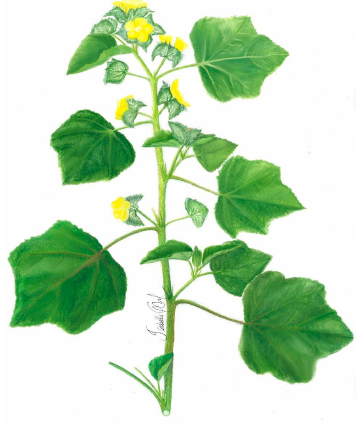
Figure 2. Malachra capitata Linn.